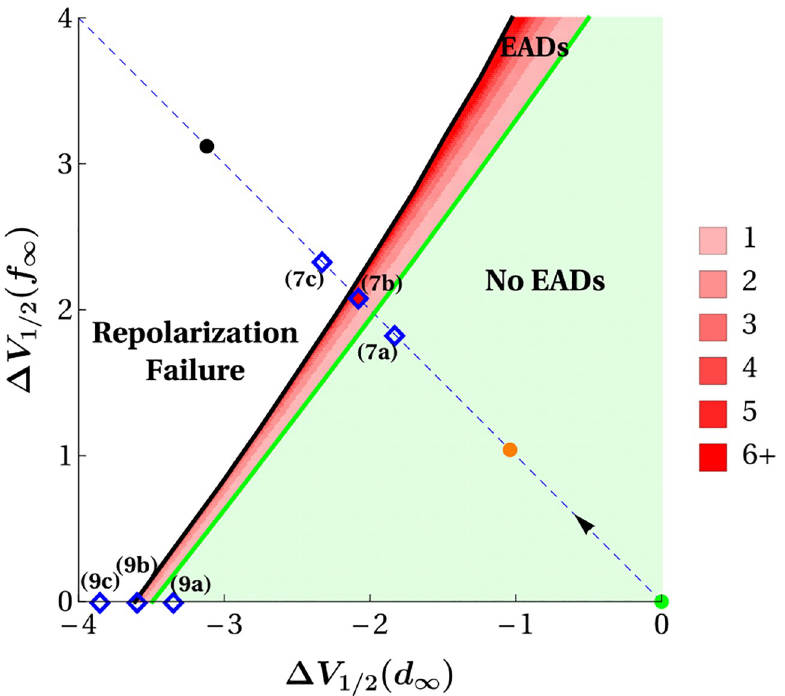
Fig 5. Model responses to a single depolarizing pulse over a uniform grid in the ( Δ V 1/2 ( d 1 ), Δ V 1/2 ( f 1 )) parameter plane (units in mV). The green region, labelled “No EADs”, denotes solutions that do not exhibit EADs before returning to rest. The white region, labelled “Repolarization Failure”, denotes solutions that can exhibit EADs around an elevated membrane potential, but remain depolarized. The red region, labelled “EADs”, contains solutions that exhibit EADs and return to rest at the end of the action potential. Darker shades of red in this region denote increasing numbers of EADs in response to the pulse. The dashed blue line segment gives the path in parameter space that corresponds to symmetric window-broadening. Green, red, orange, and black disks along this path correspond to the specific parameter values that produce the color-matched window regions and model responses shown in Fig 3. Blue � markers labeled 7a, 7b, 7c and 9a, 9b, 9c are parameter sets whose solutions are viewed in ( f , x , V ) phase space in Figs 7 and 9, respectively. The slope ( > 1) of the green curve, which marks the boundary between the “No EADs” and “EADs” regions, explains why left shifts in d 1 ( V ) are a more reliable source of EAD production than right shifts in f 1 ( V ). The red “EADs” region possesses finer structure than the light green or white regions. Increasingly darker shades of red are used to indicate incremental increases in the number of EADs produced: 6 or more EADs are produced within the darkest shade of red, and some parameter combinations in this region produce solutions with as many as 40 EADs. The dia- gram shows that variation in the number of EADs elicited in this red region is organized into bands that gradate the transition from “No EADs” to “Repolarization Failure” and that the size of the bands declines corresponding to more EADs. That is, the red “EADs” region is domi- nated by solutions exhibiting few, rather than many, EADs. This finding predicts that action potentials with relatively few EADs should be more readily observed in experimental settings, as does indeed seem to be the case in published voltage traces from isolated myocytes [7, 14, 15]. The finding (both in the model and experimentally) that EADs are produced more effec- tively by left shifts in d ( V ) than right shifts in f ( V ) is evident in Fig 5. The curve that sepa- 1 1 rates the “No EADs” region from the “EADs” region (green line) is approximately linear with slope s � 1.34. Because the slope is greater than 1, it takes a larger change in Δ V ( f ) than in 1/2 1 ( d ) to move from a parameter combination producing a pure action potential to one Δ V 1/2 1 producing an action potential with EADs.